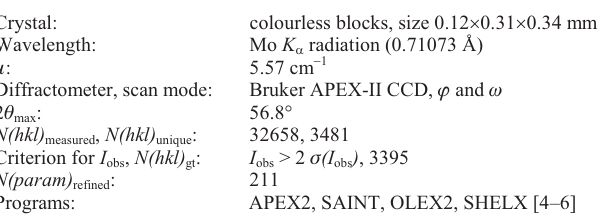
Table 1. Data collection and handling.